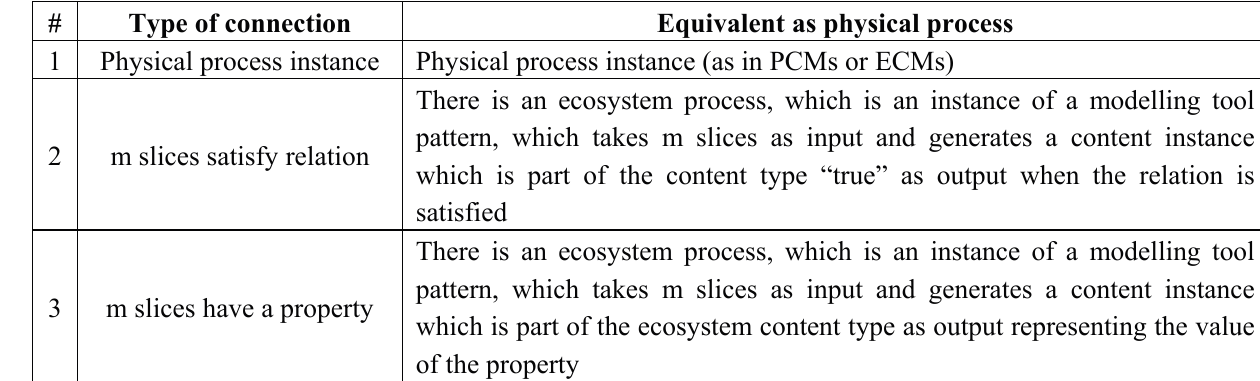
Table 1 . Types of connection as physical